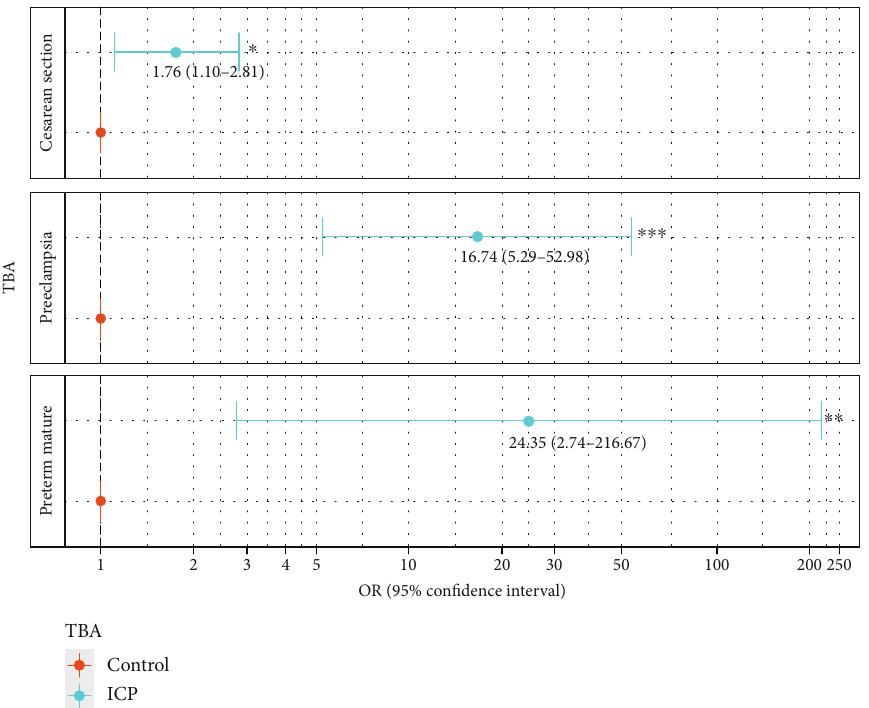
Figure 2: Adverse pregnancy outcomes in ICP and controls. Women with ICP were more likely to have preeclampsia, cesarean section, and preterm birth than controls. ICP — patients with bile acids > 10 μ mol/l . ICP: intrahepatic cholestasis of pregnancy; TBA: total bile acid. Adjusted for maternal age, pregestational BMI, and TBA level, with (cesarean section and preterm birth) or without preeclampsia (preeclampsia). Table 4: Adverse e ff ects in UDCA and non-UDCA ( n (%)). UDCA ( N = 73 )